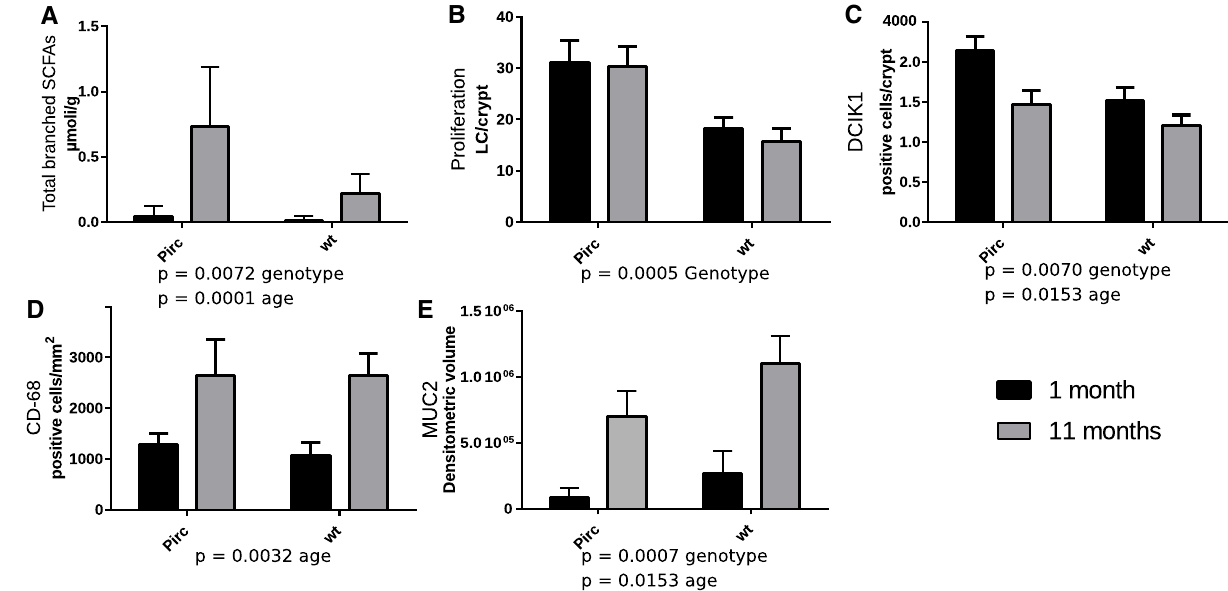
Figure 6. SCFAs quantification in faecal samples and mucosal functional parameters in rat colon mucosa from Pirc and wt rats sampled at T1 (black columns) or T11 (grey columns). Differences were assessed by two-way ANOVA testing for genotype and age effects, and their